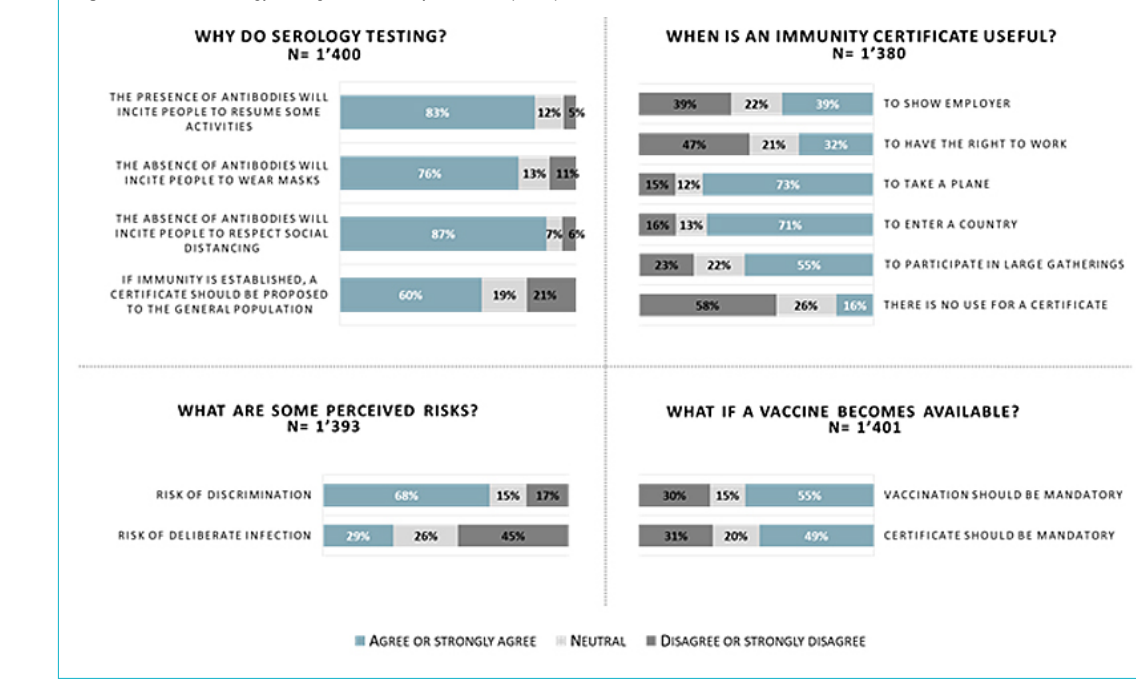
Figure 2: Overall serology testing and immunity certificate